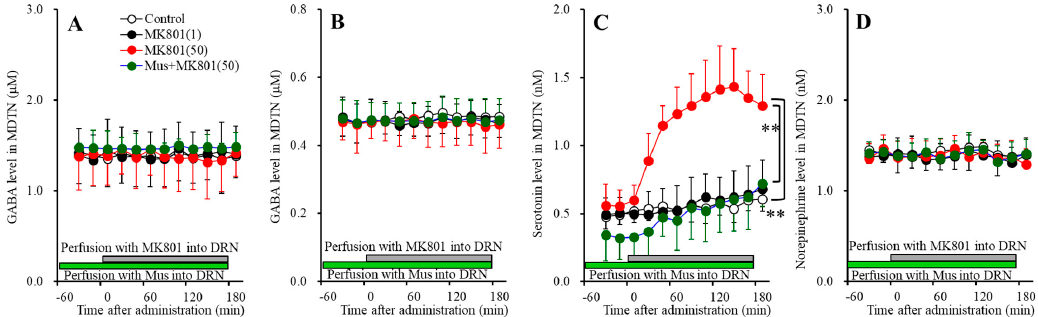
Figure 7. Concentration-dependent effects of local administration of MK801 (1 and 50 μ M) into the DRN on extracellular levels of L -glutamate ( A ), GABA ( B ), serotonin ( C ) and norepinephrine ( D ) in the MDTN (Study_4). Ordinates: mean ± SD ( n = 6) of extracellular transmitter levels ( μ M or nM); abscissa: time after MK801 administration (min). Green and gray bars indicate Perfusion with muscimol and MK801 into the DRN, respectively. * p < 0.05, ** p < 0.01; relative to control or 50 μ M MK801 by MANOVA with Tukey’s post hoc test.